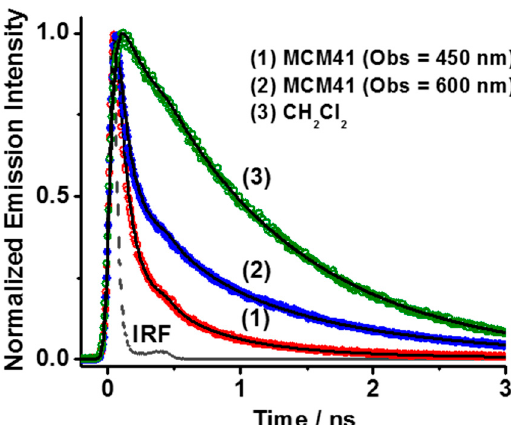
Figure 6. Normalized (to the maximum of intensity) magic-angle emission decays of DCM@MCM-41 composite (initial dye concentration: 1 × 10 − 4 M) in dichloromethane suspensions and comparison with the free dye in dichloromethane solution exciting at 371 nm and observing at ( 1 ) 450 nm and ( 2 ) 600 nm. The observation wavelength for the free dye is 600 nm. The solid lines are from the best multi-exponential fits to the experimental data. IRF is ~70 ps.